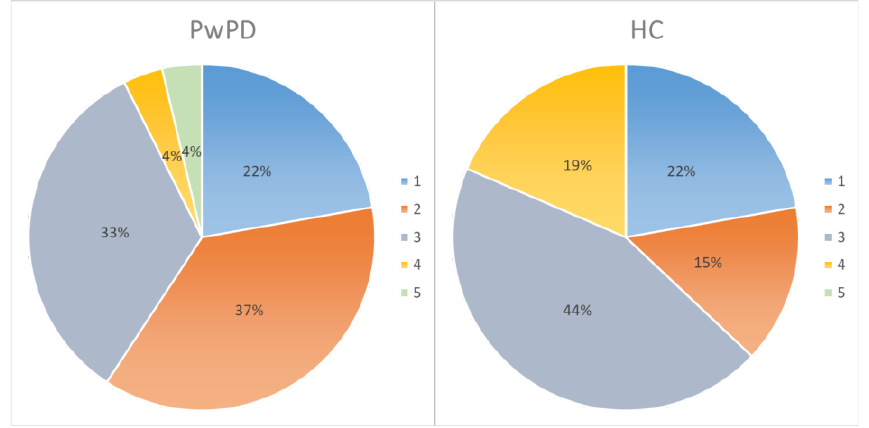
Figure 4. Percentages relating to the self-reported competence in using several technologies for each group. PD, Parkinson’s disease; HC, healthy control.